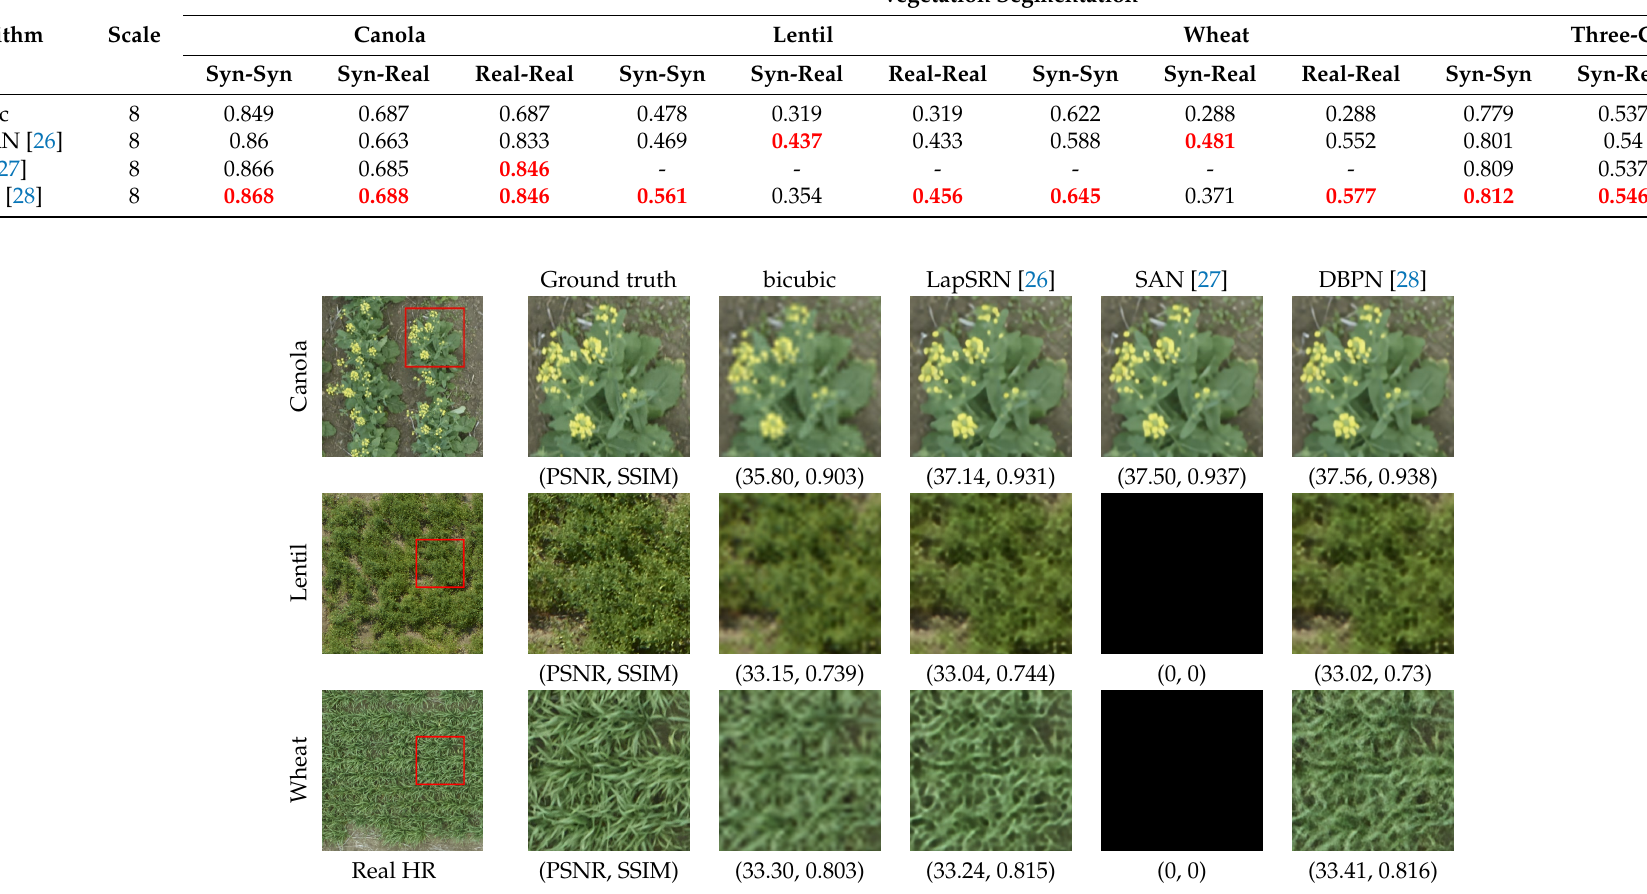
super resolution with different algorithms for the synthetic-synthetic, synthetic-real, and real-real experiments. The highest ×